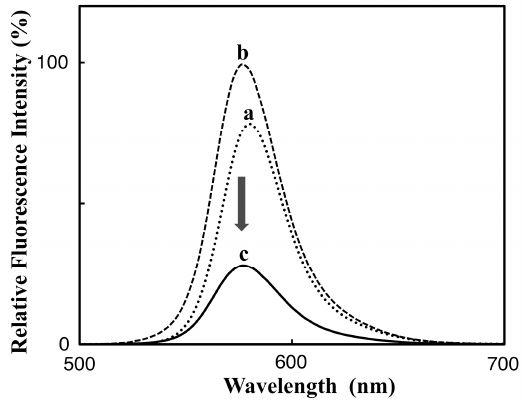
Figure 3. Fluorescence emission spectra ( λ ex = 523 nm) at pH 7.4 (10 mM Hepes-NaOH, 0.10 M NaCl) and 25 °C: (curve a ) 5.0 µM TAMRA-Phos-tag (dotted curve), λ em = 580 nm; (curve b ) 5.0 µM TAMRA-PEA (broken curve), λ em = 577 nm; (curve c ) 1:1 mixture of 2.5 µM TAMRA-Phos-tag and 2.5 µM TAMRA-PEA (solid curve), λ em = 577 nm.